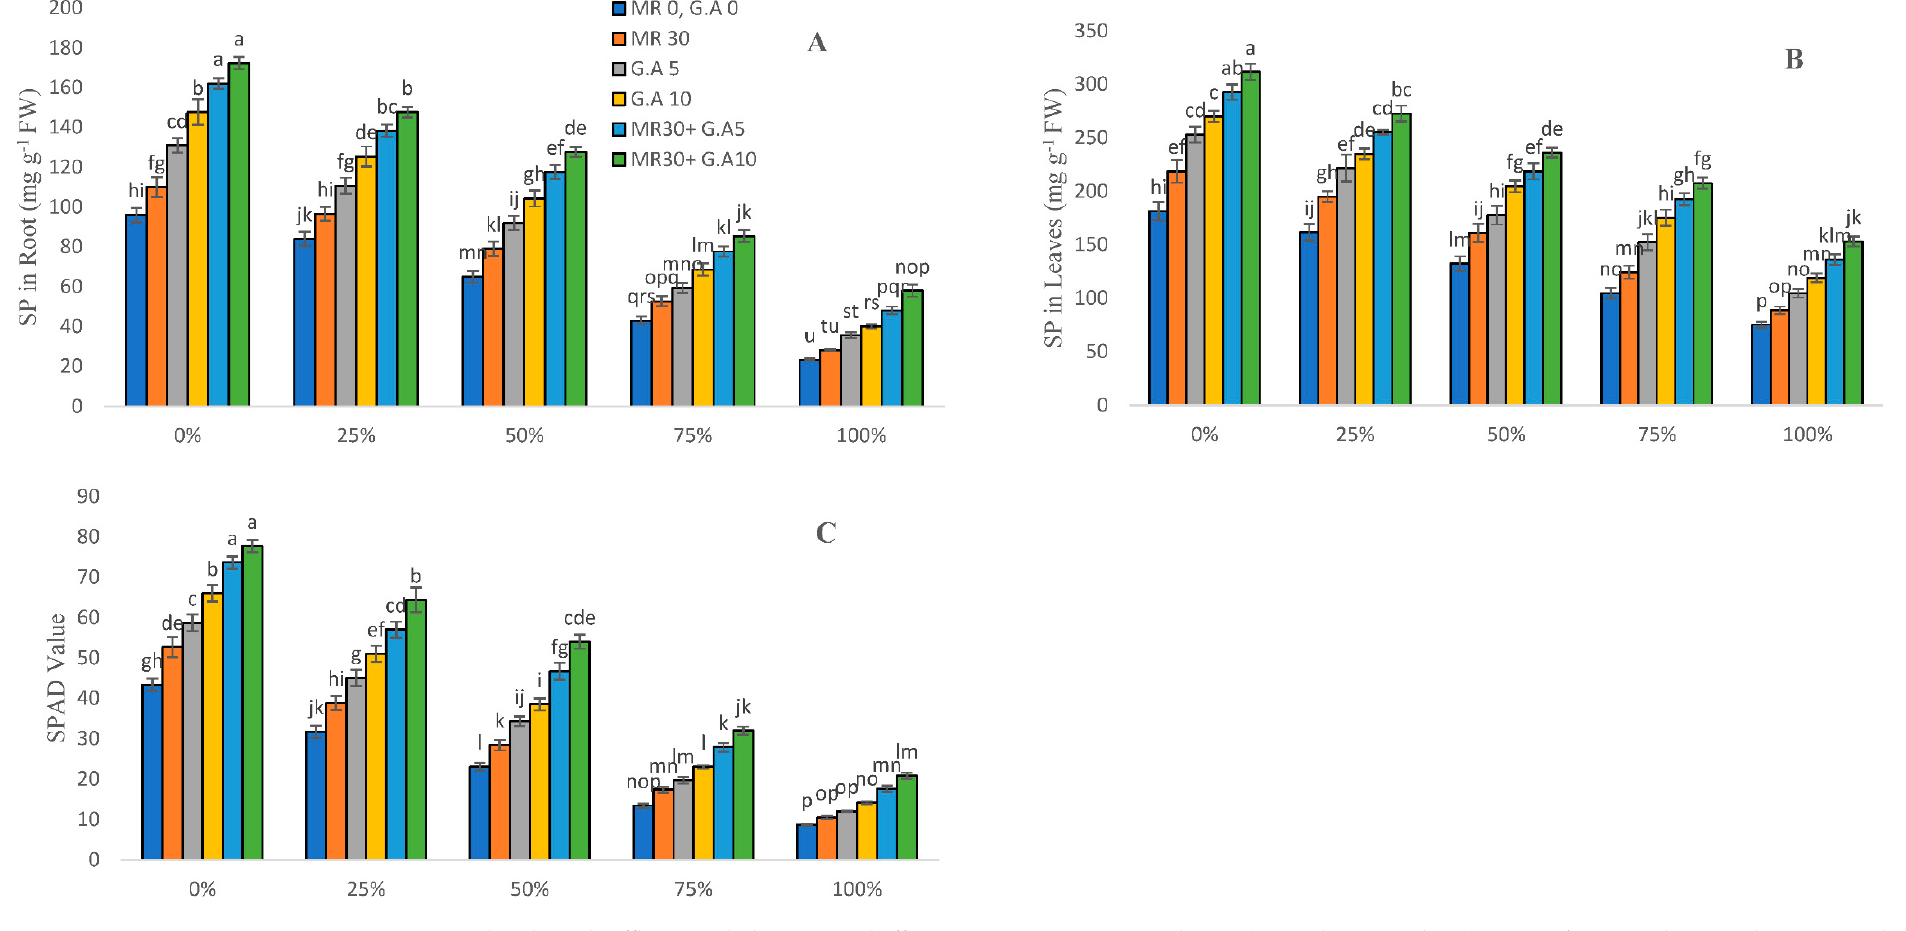
Figure 2. Surgical and textile effluent and glutamic acid effect on SP in root ( A ), SP in leaves ( B ), and SPAD value ( C ) in Sorghum L . Values are demonstrated as means of three replicates along with standard deviation. Different small letters indicate that values are significantly different at p < 0.05 .